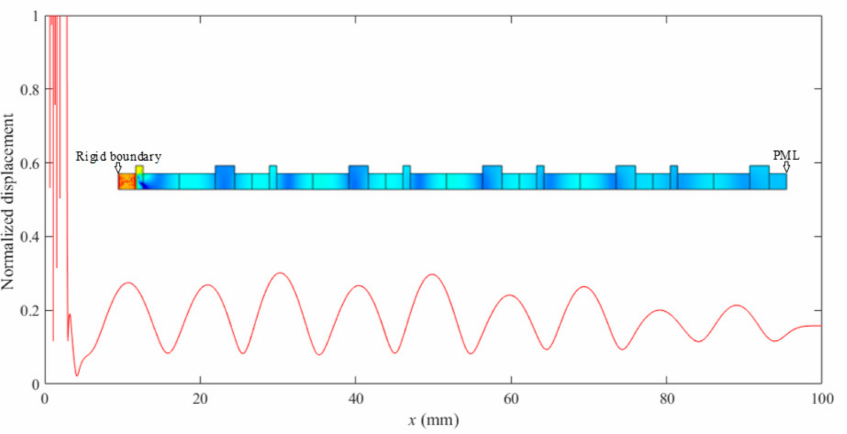
Figure 4. RP singularity and subsequent topology interface state. ( a ) The RPs of PC plates with different parameters are calculated at a Weyl frequency of 0.305 MHz. ( b ) The energy density spectrum normalized by the flat panel at ( p , q ) = (0.35, 0.45).